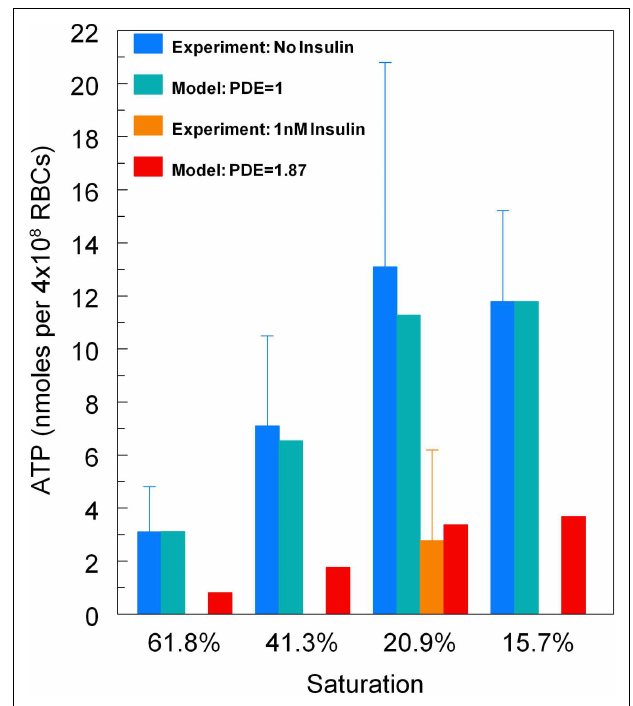
FIGURE 4 | Model predictions for totalATP release vs. hemoglobin saturation. For baseline levels of PDE3 activity, predicted ATP release matches experimental measurements (Sprague and Ellsworth, 2012). For an 87% increase in PDE3 activity, ATP release decreases as seen for erythrocytes incubated in insulin (Hanson et al., 2009). Here ATP release has been normalized so that at 15.7% sO 2 the model matches the ATP release measurements without